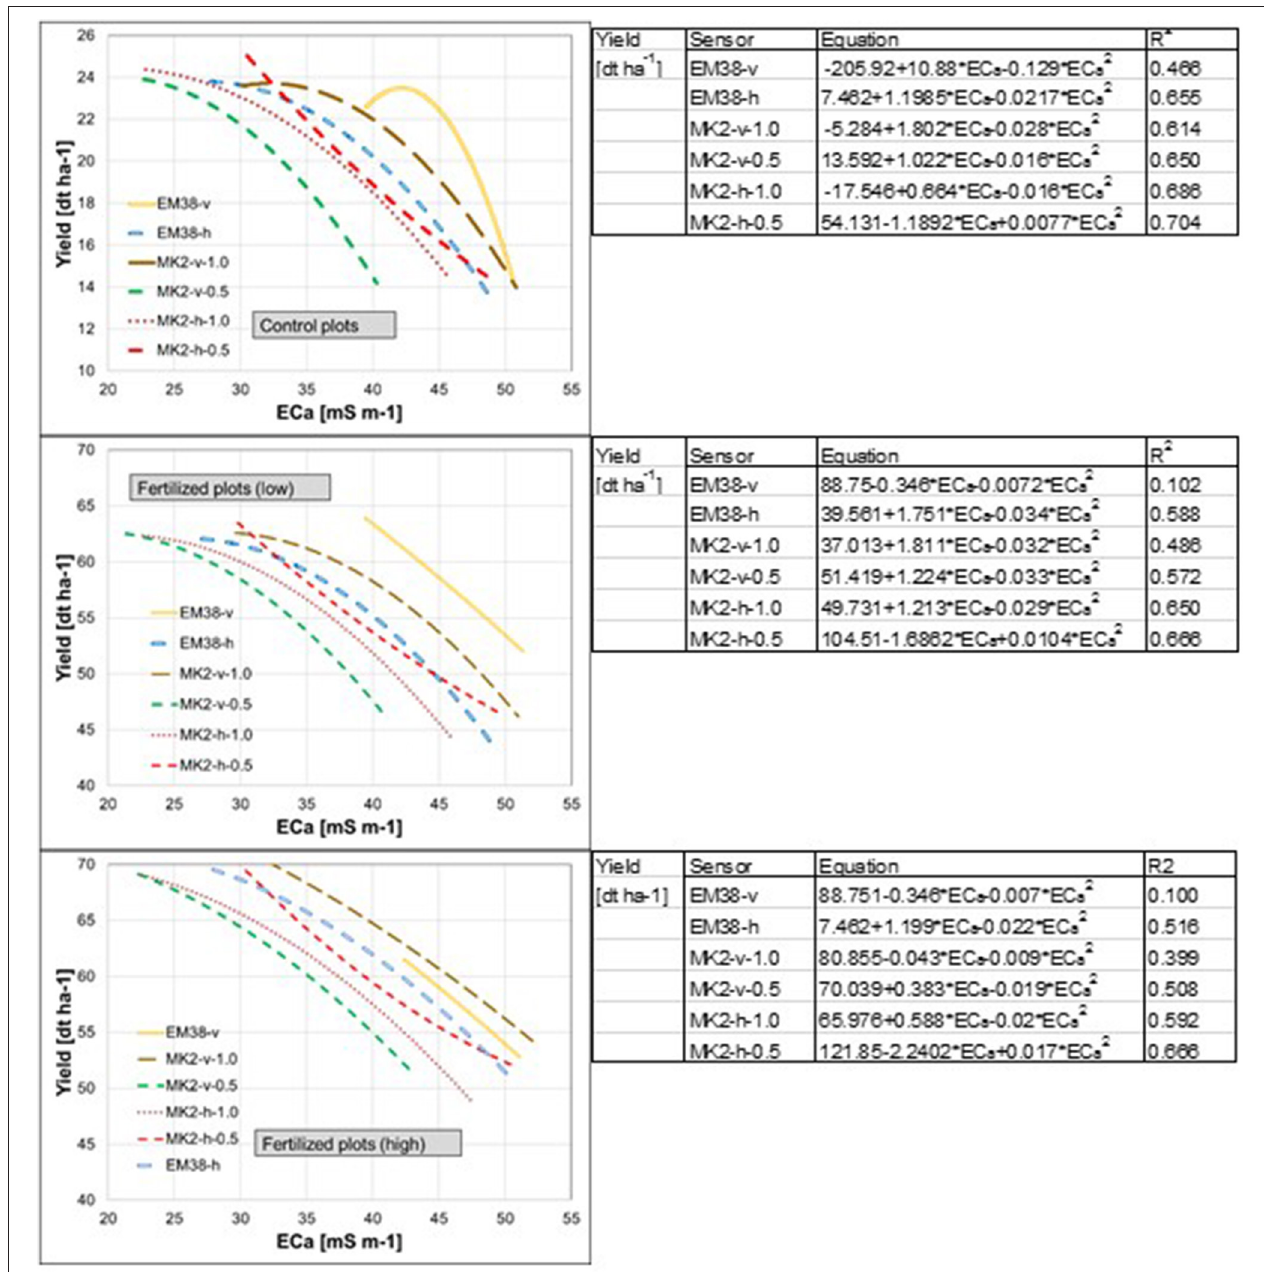
FIGURE 7 | Relationships between EC a and yields for the control and the fertilized plots with low and high levels of N